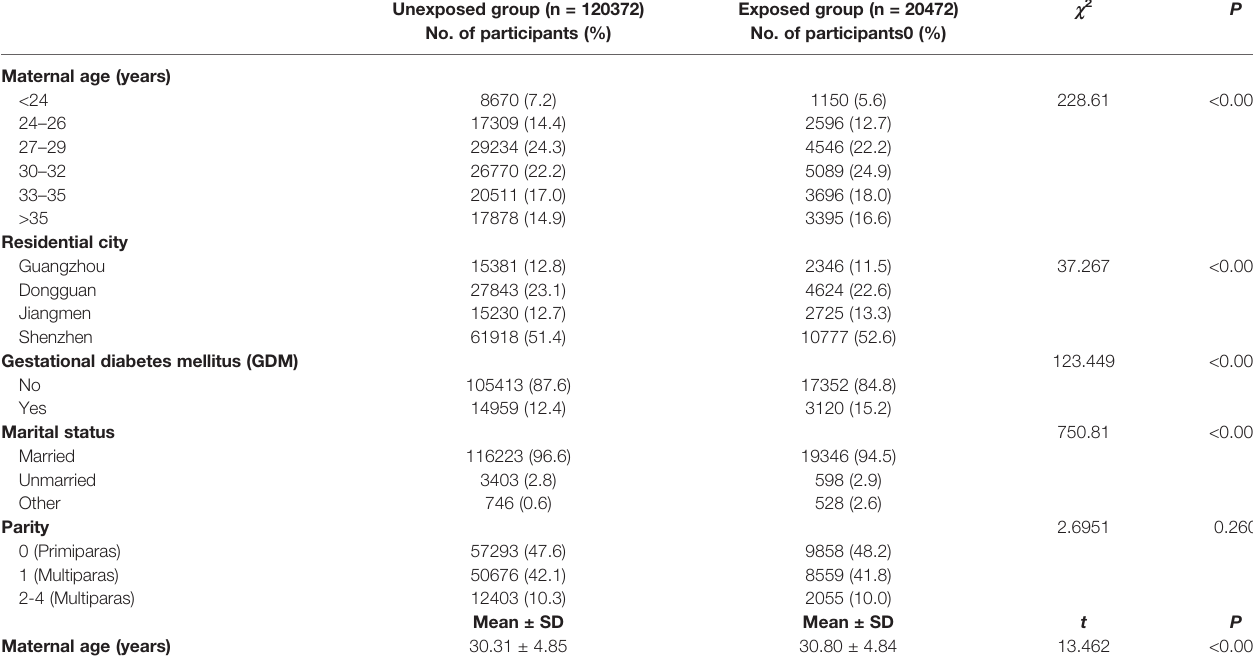
TABLE 1 | General characteristics of study